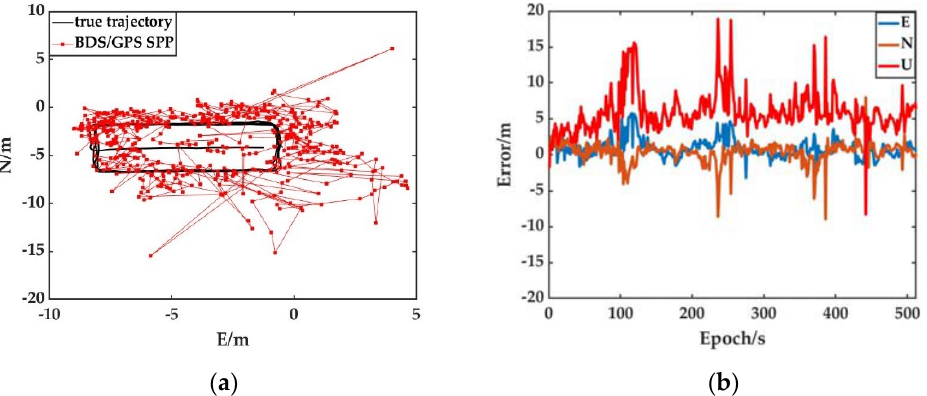
Figure 5. BDS/GPS SPP positioning results (The positioning error is the difference between BDS/GPS SPP and the reference value, which is obtained epoch by epoch). ( a ) Positioning trajectory. ( b ) Posi- tioning error.